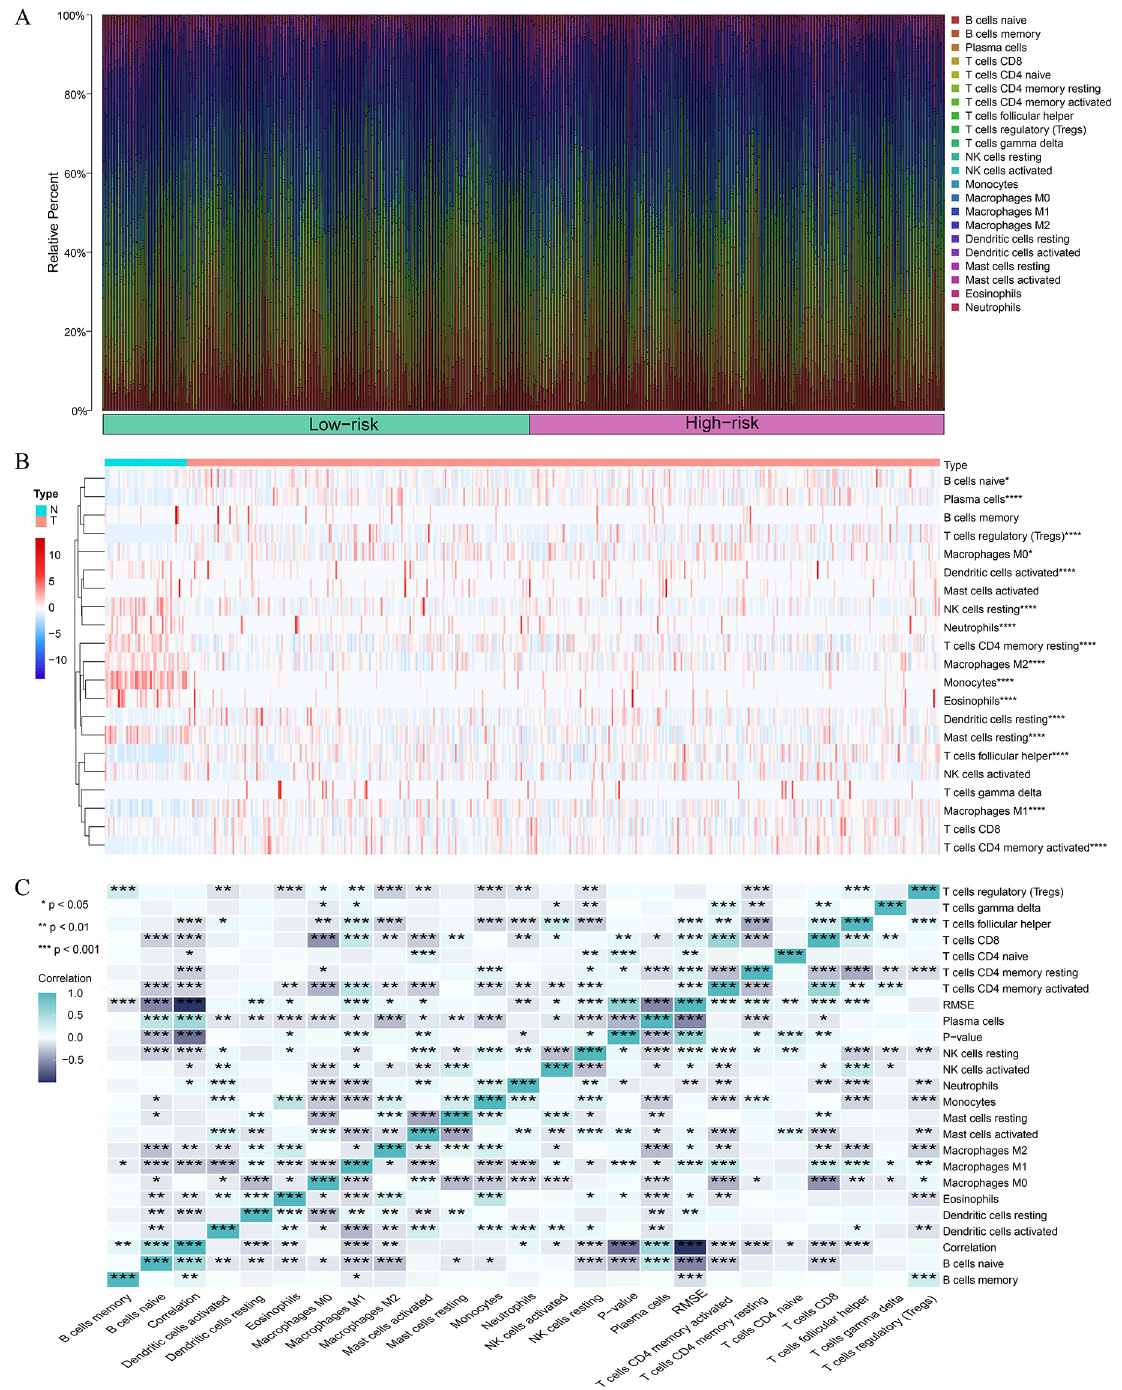
Fig 12. The relationship between the genes and immune cell infiltration in the TCGA cohort. A Bar plot showed the proportion of 22 immune cells with each sample. B. The heat map showed the level of immune cell infiltration of each sample between normal tissues and LUSC tissues. C. Correlation matrix of all 22 immune cells